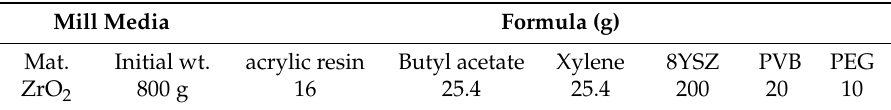
Table 1. The formula of electrolyte substrate